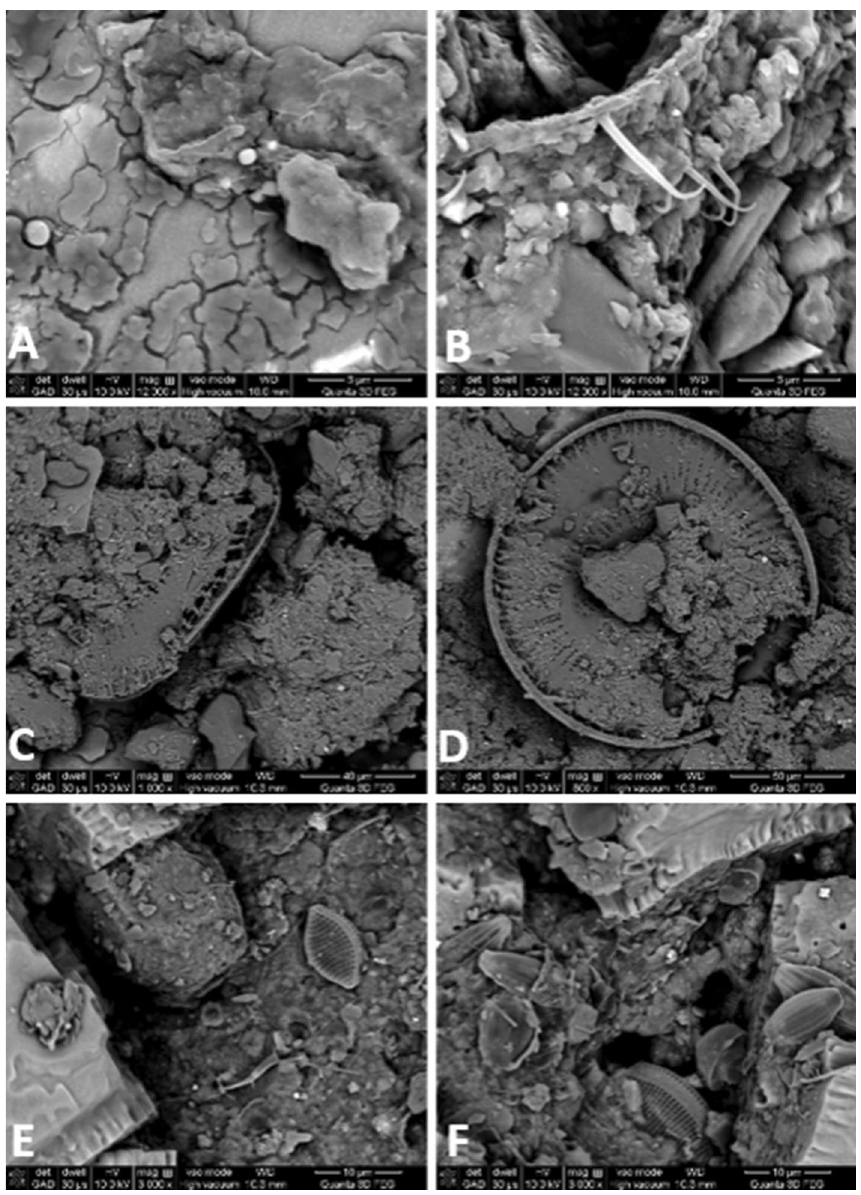
Figure 8. Scanning electron microscopy (SEM) photographs of sediment samples from Tekirghiol ( A , B , 12,000× magnification), Amara ( C , D , 1000×) and Ursu ( E , F , 3000×) lakes, revealing details of phyto- and zooplankton and inorganic